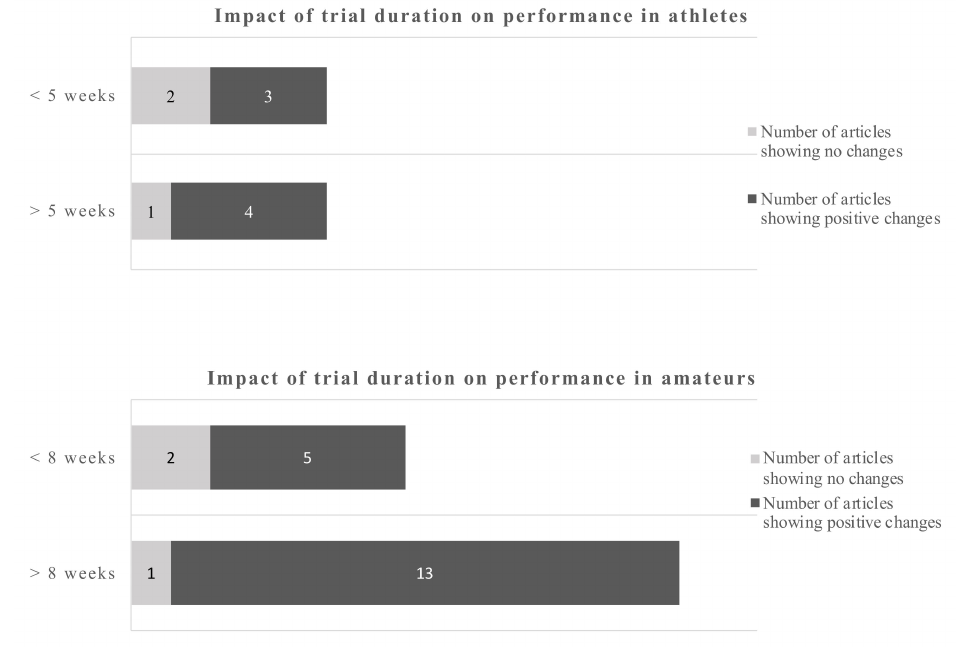
Figure 2. Impact of trial duration on performance-related outcomes in athletes and amateurs by dichotomous split.